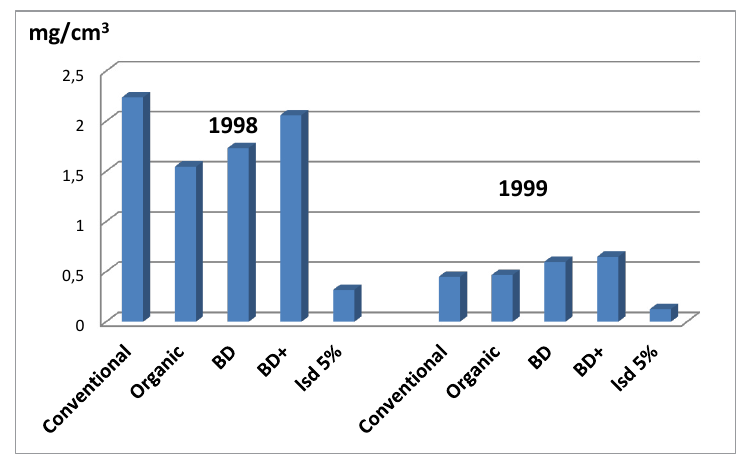
Figure 7: Root dry matter production in August of two years as affected by systems